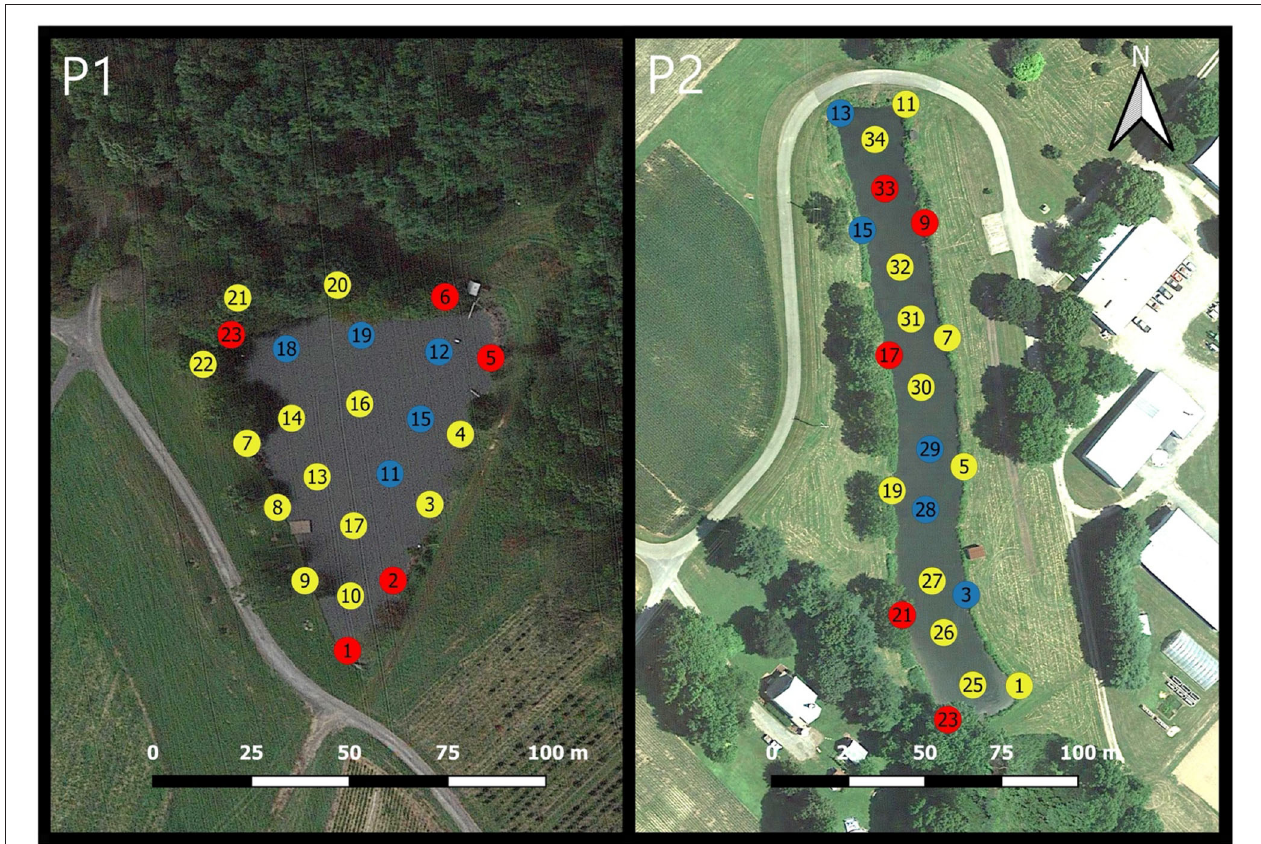
FIGURE 5 | Mean relative differences (MRD) of diatoms over the 2-year period for Pond 1 (P1) and Pond 2 (P2). Locations with MRD values below the 25th percentile are displayed in blue, locations above the 75th percentile are displayed in red, and locations between the 25 and 75th percentile are displayed in